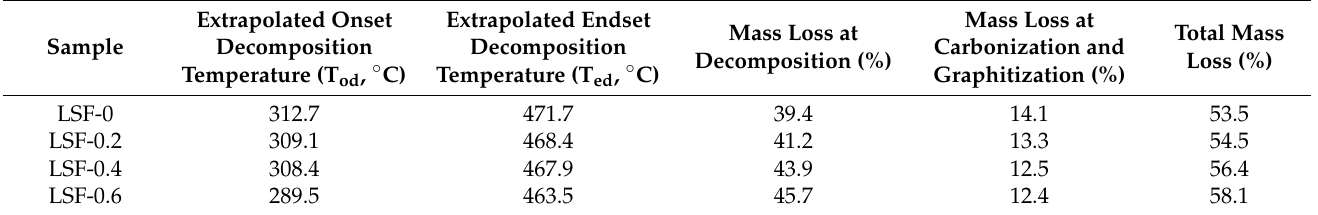
Table 1. Decomposition temperatures and mass loss analysis of the LSF samples.